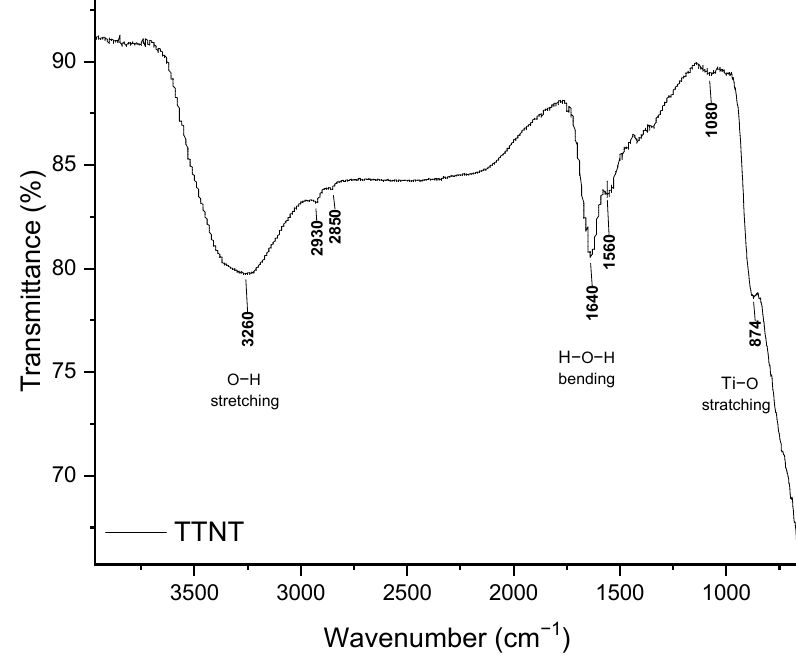
Figure 7. FTIR spectra of Ti sample after alkaline hydrothermal treatment (TTNT).